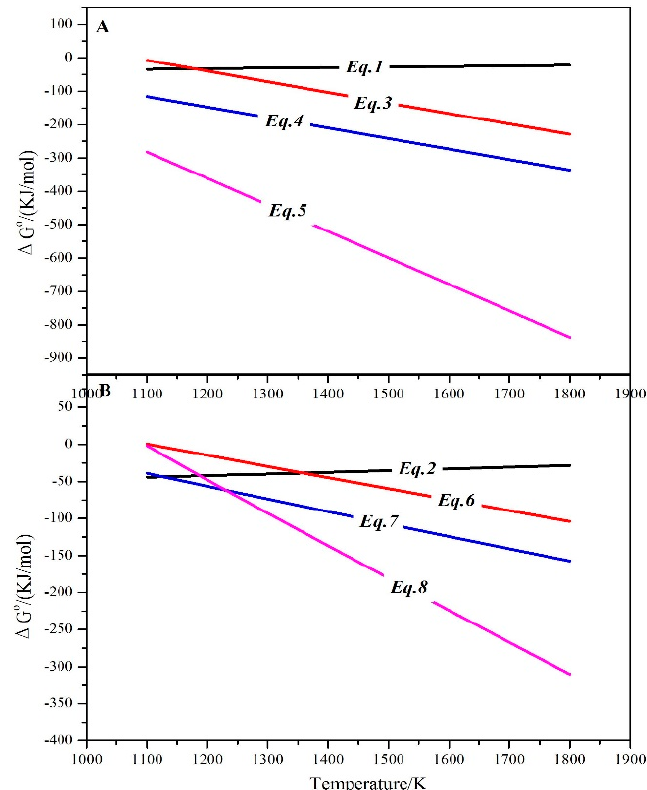
Figure 4. Relationships of reduction roasting reactions of iron minerals. ( A ) Reduction of Fe 2 SiO 4 ; ( B ) reduction of FeAl 2 O 4 .